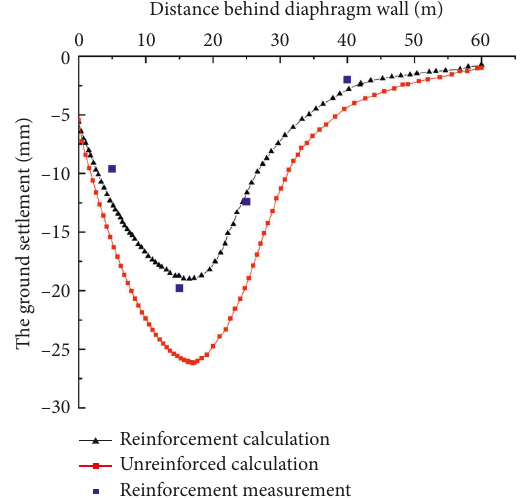
Figure 5: Curves of the ground settlement behind the wall.